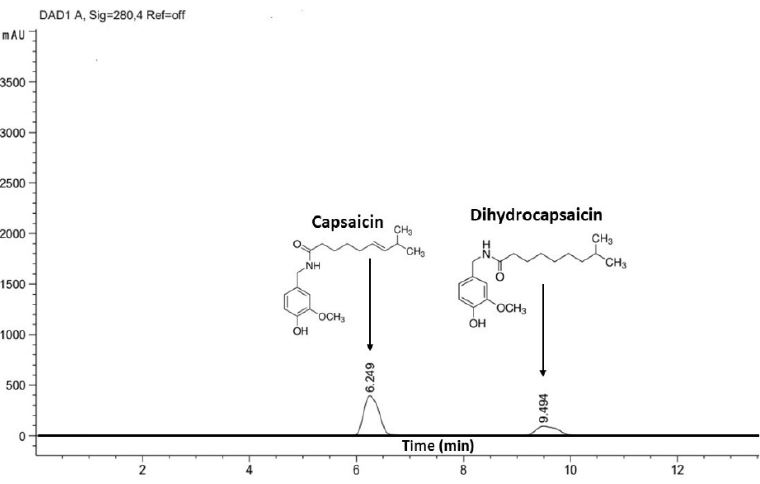
Figure 4. Chromatogram of capsaicin and dihydrocapsaicin in habanero pepper fruits grown in the southeast of Coahuila.